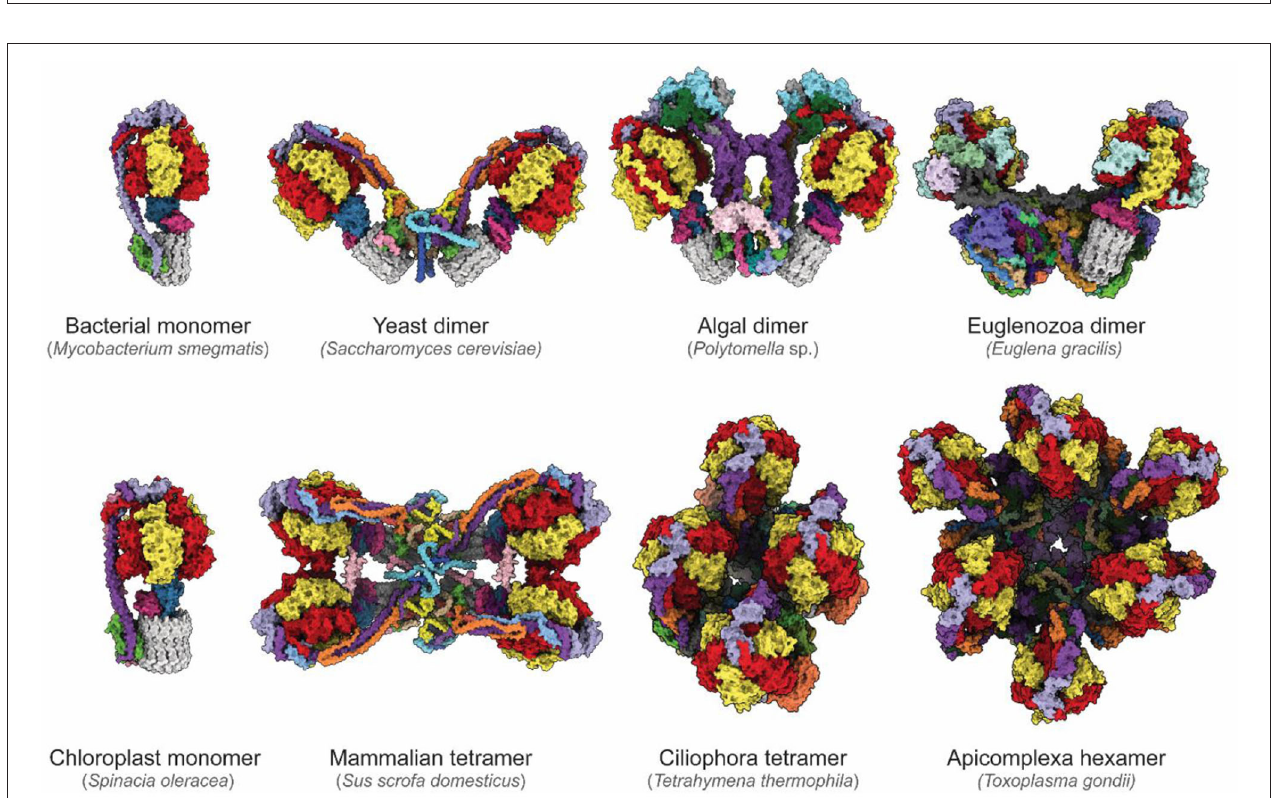
FIGURE 4 | Diversity of ATP synthases. Atomic models of ATP synthases from diverse species. Homologs of subunits α , β , γ , δ , ε , and c are colored red, yellow, blue, pink, purple, and gray, respectively. From the left to right, top to bottom: Mycobacterium smegmatis (PDB: 7JG5) (Guo et al., 2021), Saccharomyces cerevisiae dimer (PDB: 6B8H) (Guo et al., 2017), Polymotella sp. dimer (PDB: 6RD4) (Murphy et al., 2019), Euglena gracilis dimer (PDB: 6TDU) (Mühleip et al., 2019), Spinacia oleracea (PDB: 6FKF) (Hahn et al., 2018), Sus scofa domesticus tetramer (PDB: 6J5K, 6ZNA) (Gu et al., 2019; Spikes et al., 2020), Tetrahymena thermophila tetramer